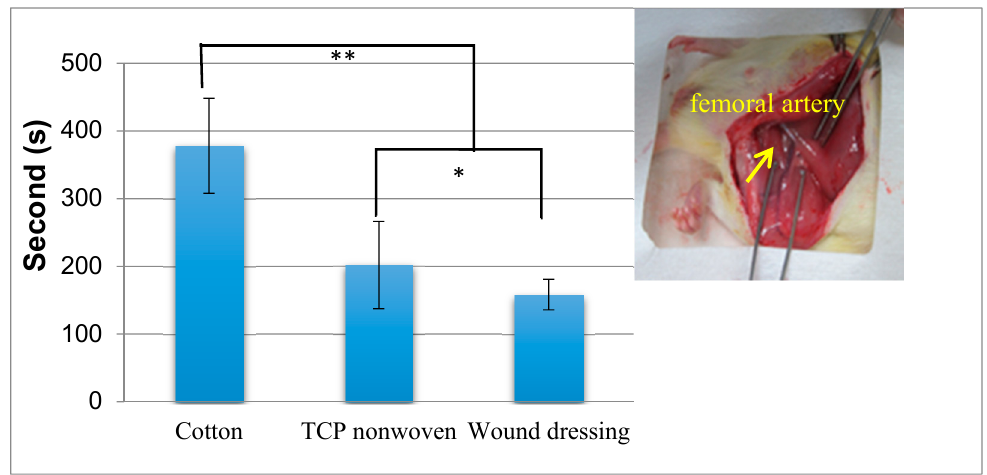
Figure 9. Comparisons of the hemostasis time of rat femoral artery injury by using cotton cloth (cotton), TCP nonwoven (TCP), and resultant wound dressing. ** p < 0.01; * p < 0.05.